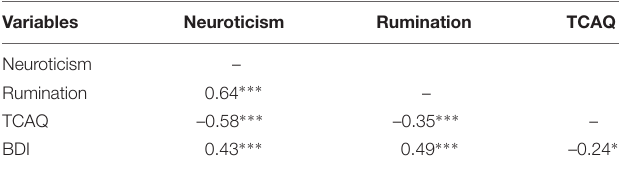
TABLE 2 | Correlation matrix in Study 1.